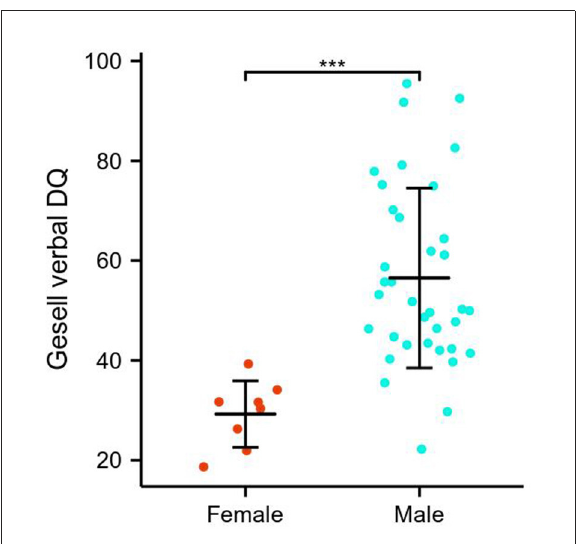
FIGURE2 Sex differences of Gesell language DQ in ASDs. *** p <